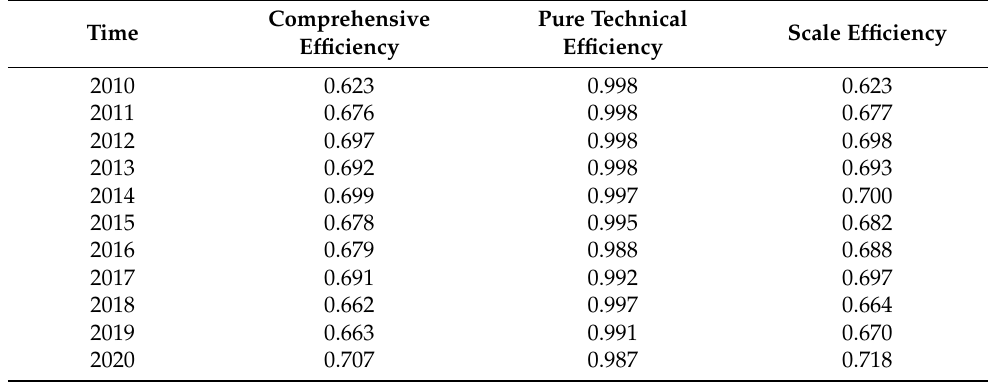
Table 6. DEA estimation results of the third stage: average of the whole